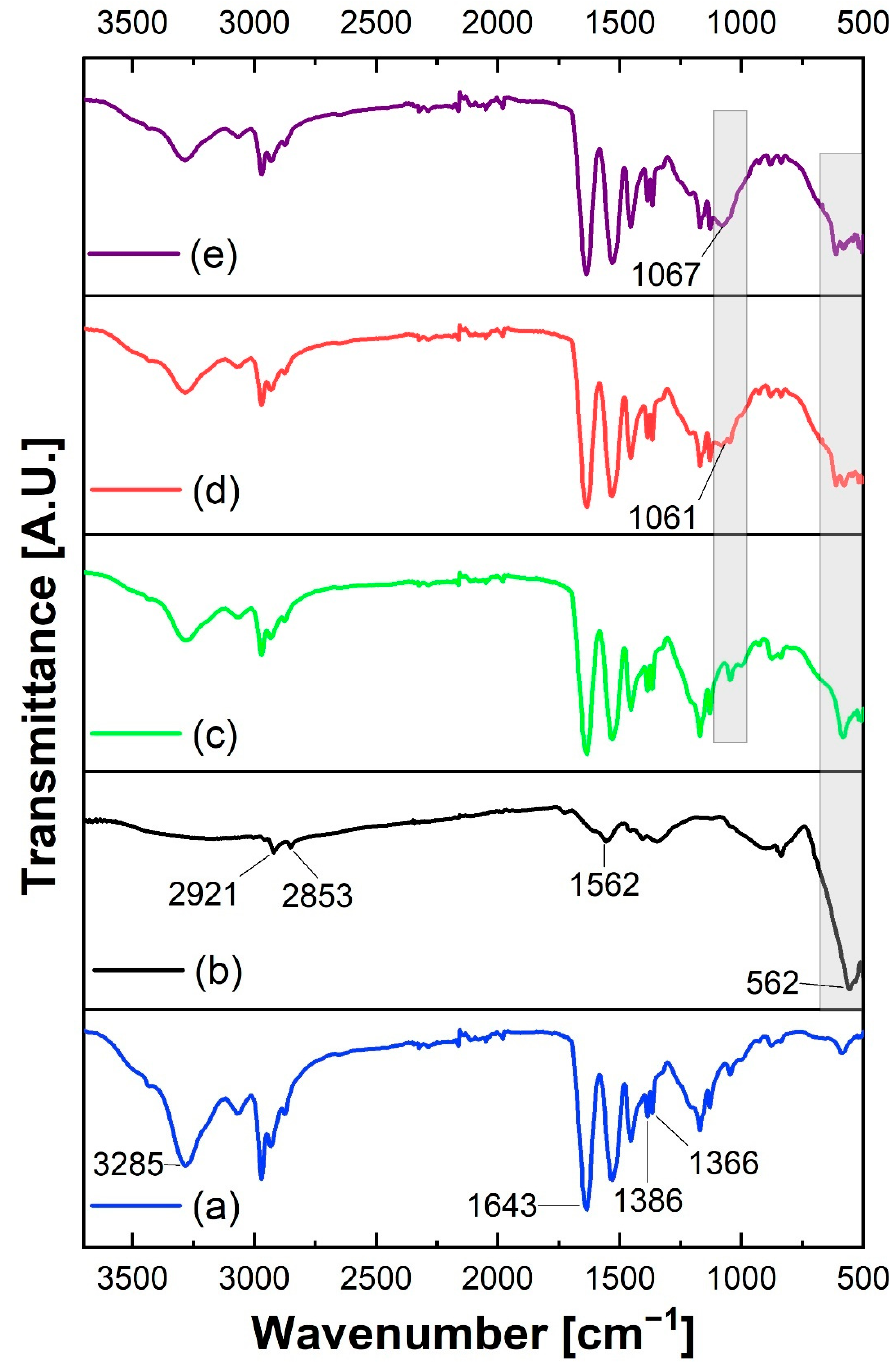
Figure 3. FTIR spectra of vacuum ‐ dried powder of ( a ) Fe 3 O 4 Nps, ( b ) Np 0 , ( c ) Np 1 , ( d ) Np 2 , and ( e ) Np 3 . They were collected over the wavenumber range of 4000 to 500 cm − 1 .